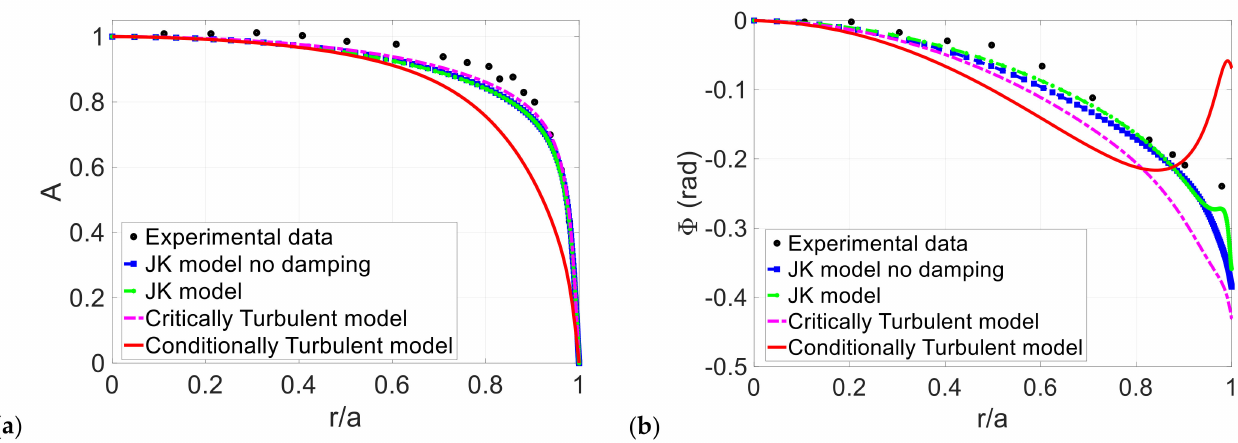
Figure 8. Comparison between experimental data and various turbulence and transition models for Case 2: Re os = 19,300, α = 16.5: ( a ) amplitude ratio; ( b )